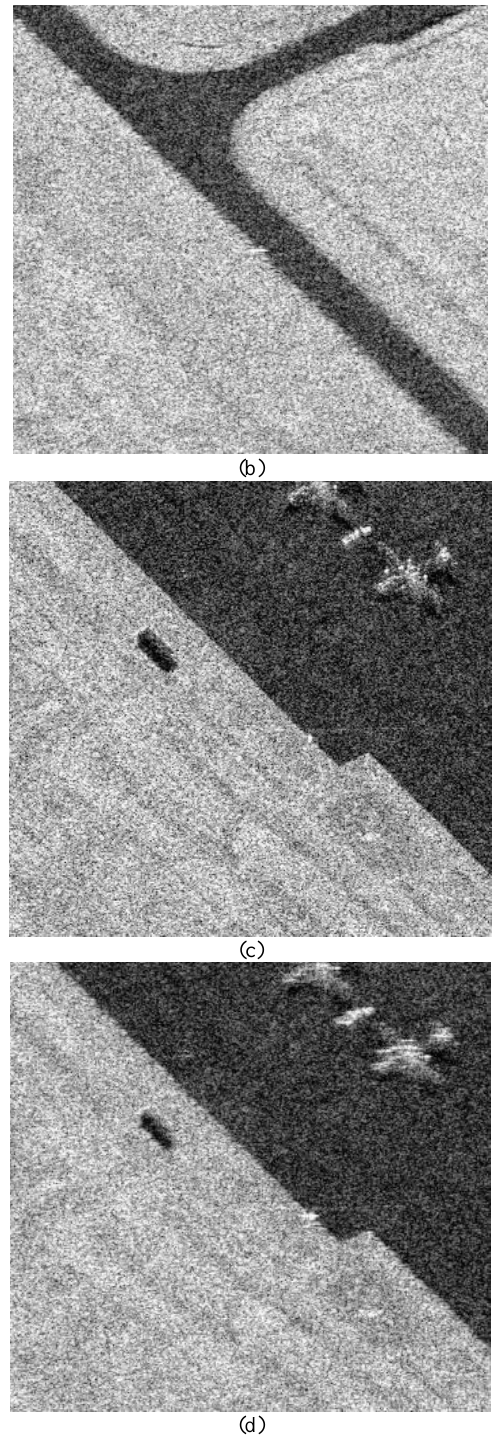
Figure 4. Comparison of ground controls of different imaging process. (a) and (c) are the results of ECS with integrated MOCO, (b) and (d) are the results of ECS without